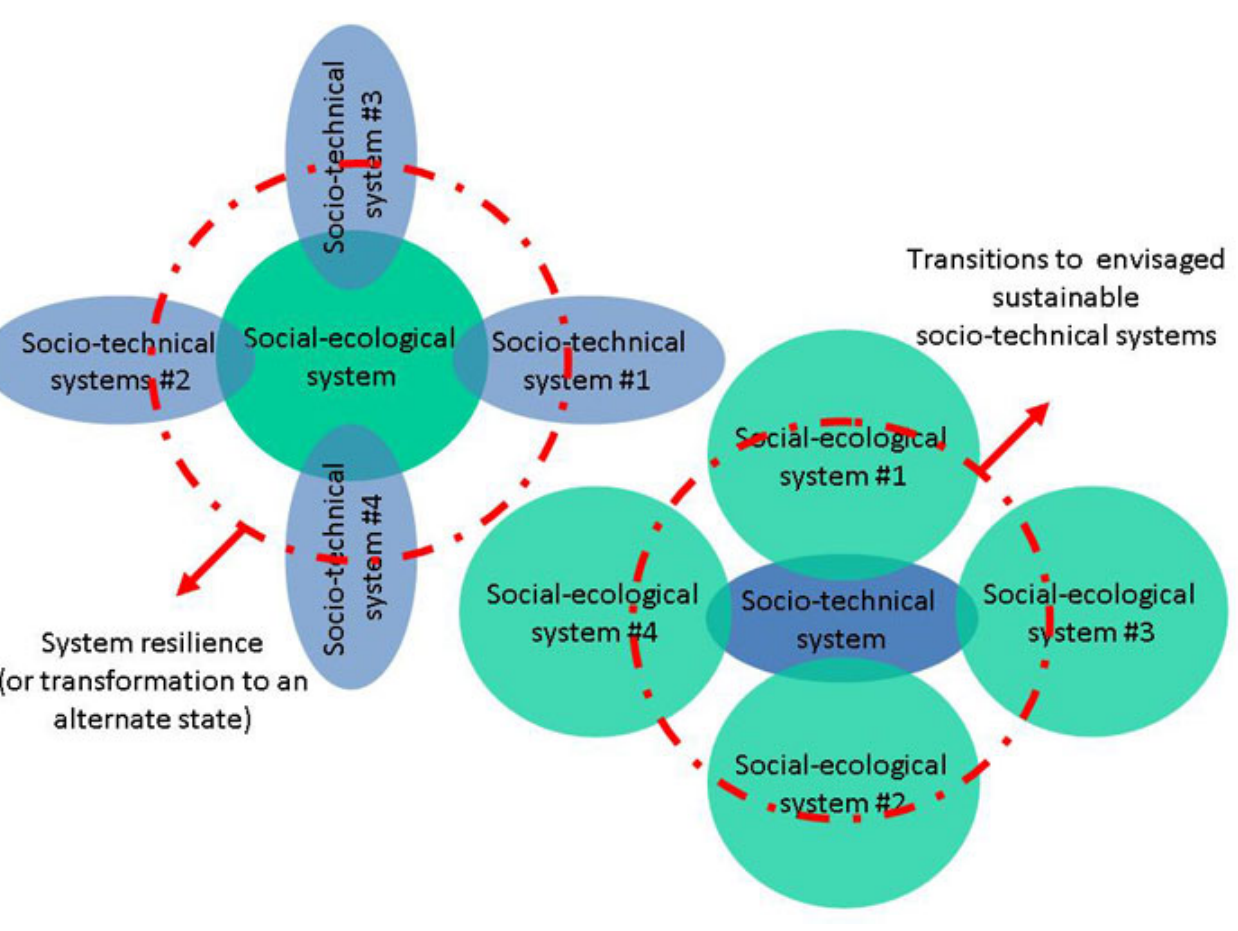
Fig. 1 . A schematic representation of differences and overlaps in the analysis and governance of social- ecological systems and socio-technical